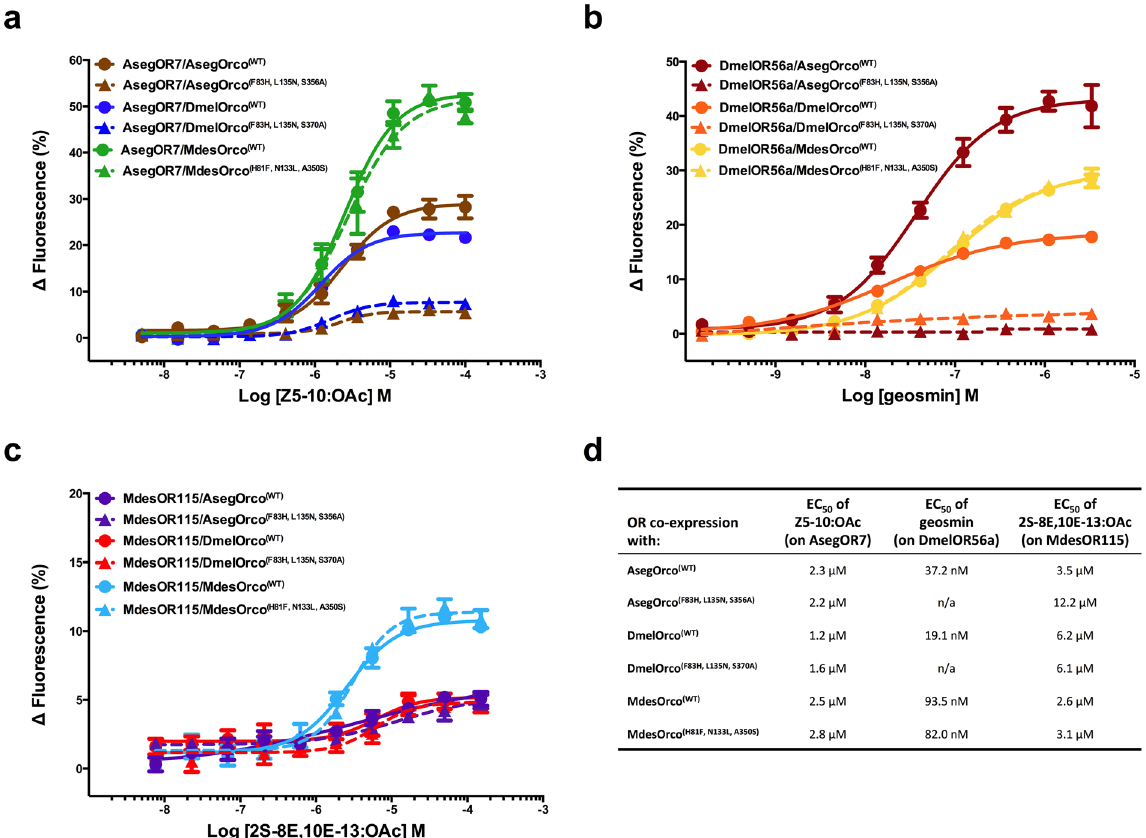
Figure 4. Response of TREx/HEK293 cells expressing Agrotis segetum (Aseg) OR7, Drosophila melanogaster (Dmel) OR56a or Mayetiola destructor (Mdes) OR115 in combination with wild-type or mutated forms of AsegOrco, DmelOrco and MdesOrco to different concentrations of the OR-specific ligands. ( a ) AsegOR7- expressing cells were tested for response to ( Z )-5-decenyl acetate (Z5–10:OAc), ( b ) DmelOR56a-expressing cells were tested for response to geosmin, and ( c ) MdesOR115-expressing cells were tested for response to (2 S ,8 E ,10 E )-8,10-tridecadien-2-yl acetate (2S-8E,10E-13:OAc). ( d ) EC 50 values for the responses shown in ( a , b and c ). Data represent the mean response ( ± SEM) of cells from three biological replicates. Note: all data points contain error bars; some are too small to be